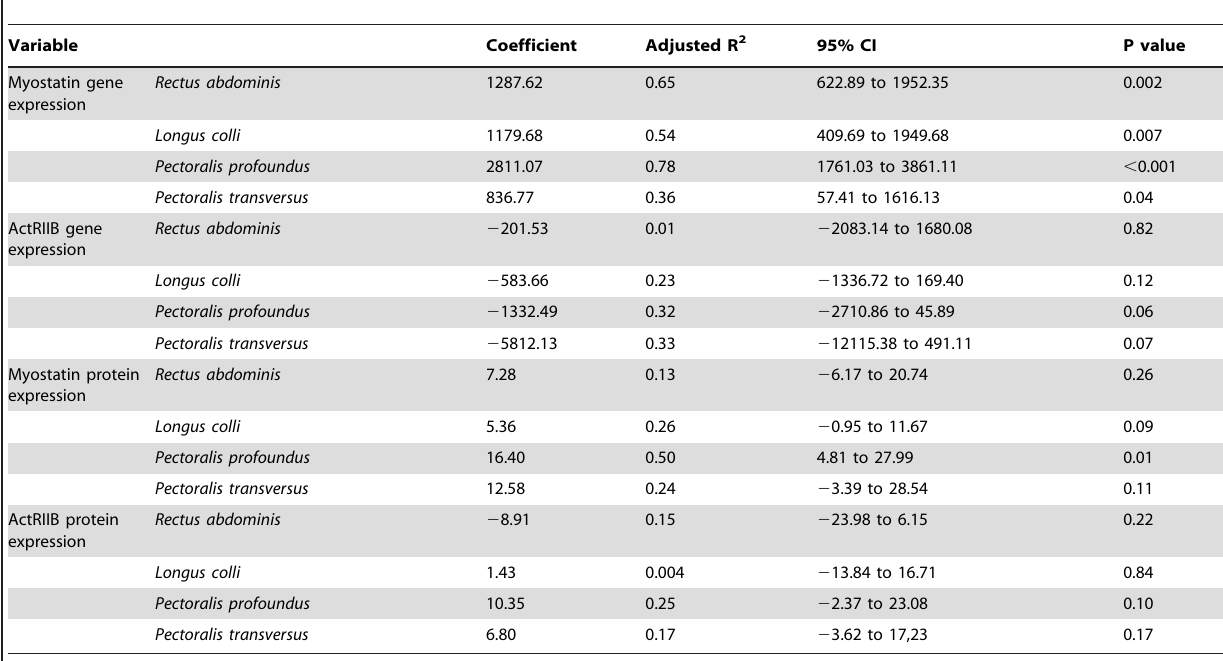
Table 4. Univariate regression analysis results for myostatin ELISA